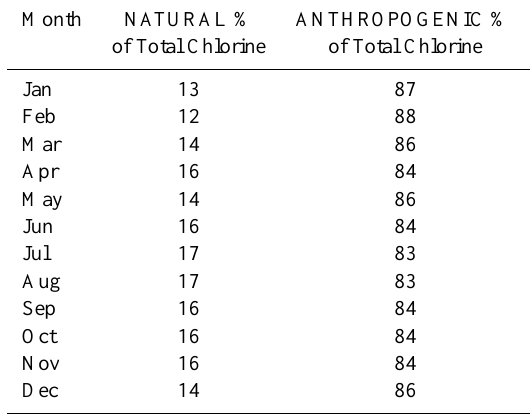
Table A3. Monthly split-factors (component percentages) derived from ocean/coastline NO x ratios that were applied to the GEIA RCEI (Reactive Chlorine Emissions Inventory) to produce natural and anthropogenic components from annual total chlorine (i.e. HCl and ClNO2 referenced in Table A4).